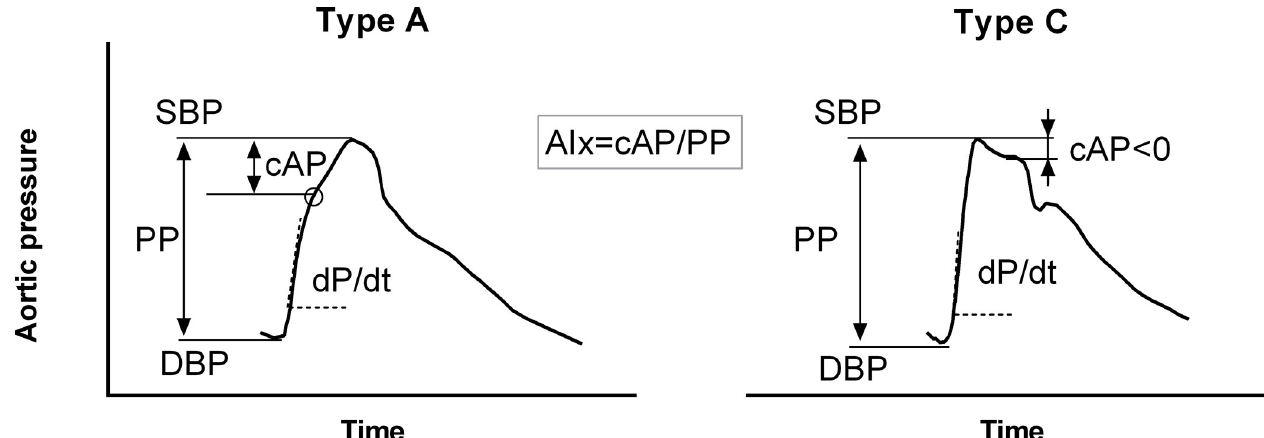
Fig 2. Aortic pulse wave analysis for the characteristic Type A and Type C phenotypes. SBP: systolic blood pressure, PP: pulse pressure, DBP: diastolic blood pressure, cAP: central augmentation pressure, AIx: augmentation index.